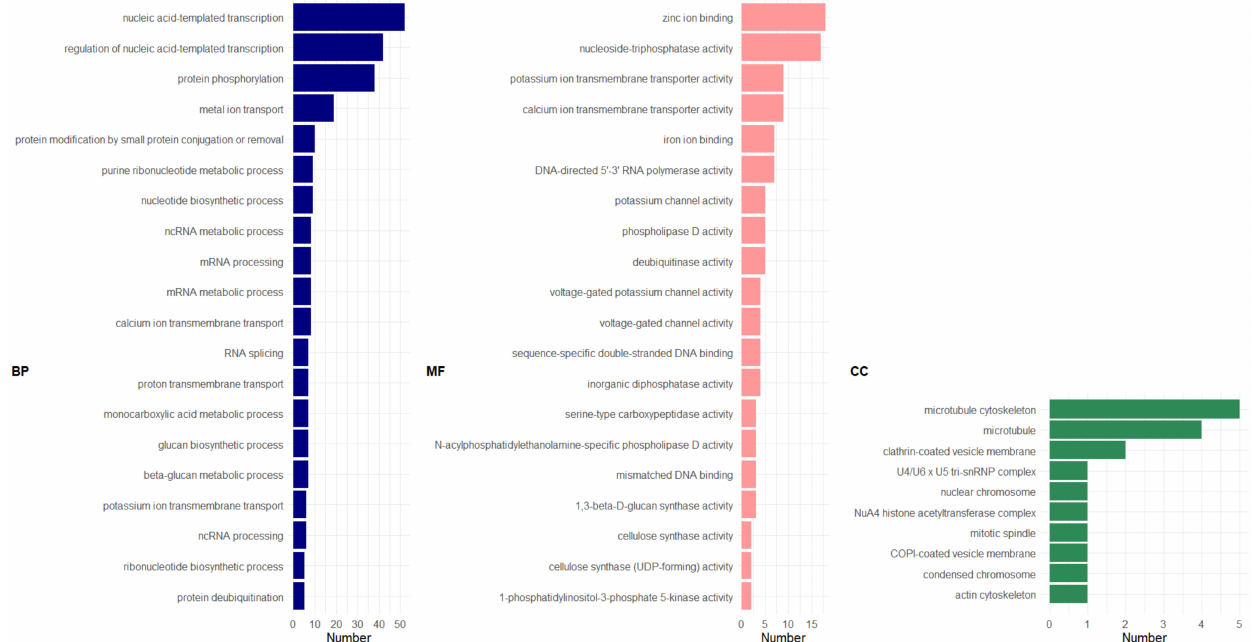
Figure 6. GO distribution of genes up-regulated in the abaca varieties but down-regulated in Pacol using PDE model for FQ. Legend: BP, Biological Process; MF, Molecular Function; CC, Cellular Component. Number indicates number of sequences or genes classified in each GO term. Figure generated using ggplot2 [57] in Rstudio [21]. GO distribution analyzed using OmicsBox